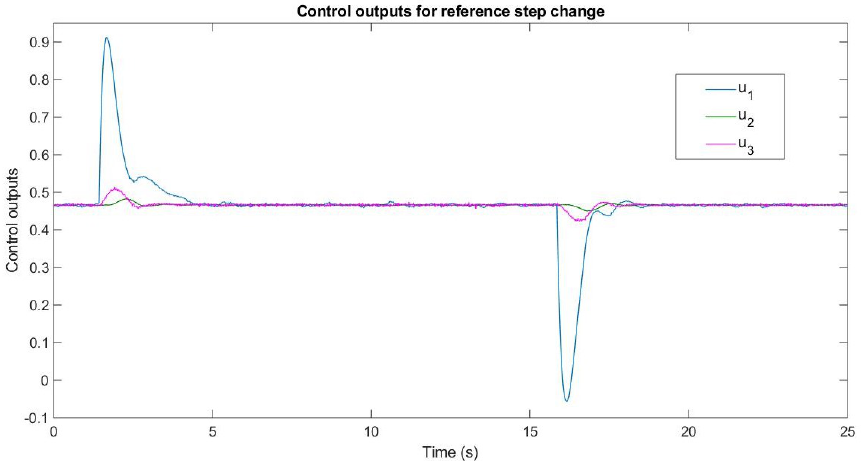
Figure 4. Experimental speed consensus with a reference step change.